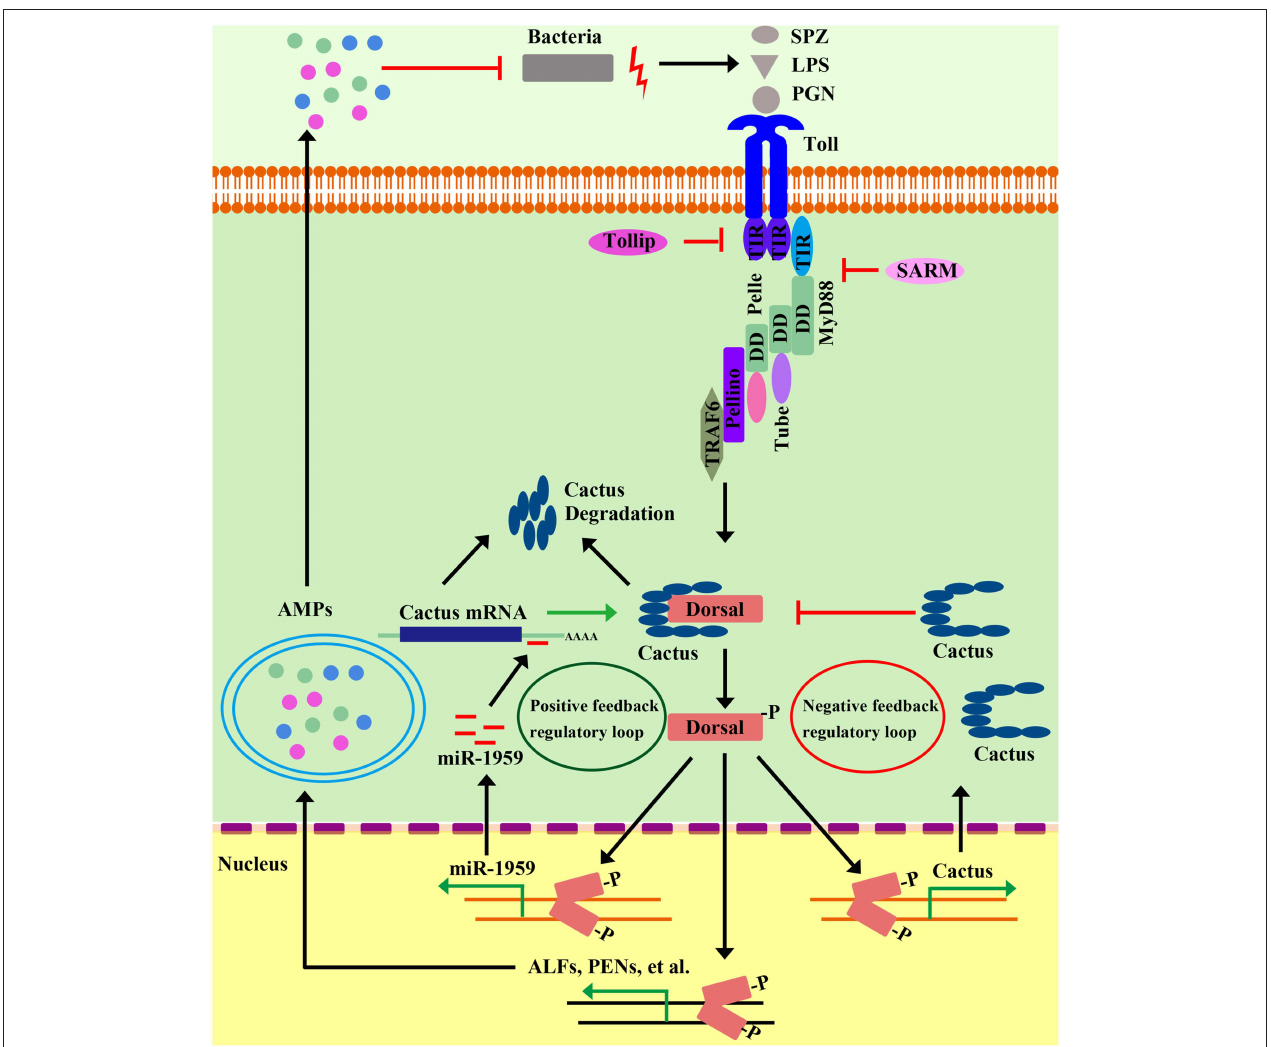
FIGURE 3 | Positive and negative regulatory events in shrimp Toll pathways. Positive regulation of the shrimp Toll pathway can amplify signaling cascades to rapidly limit and clear invading pathogens. In microbial recognition, intracellular signaling leads to activation of Dorsal, which in turn induces the transcription of a microRNA gene, miR1959. MiR1959 can target the mRNA of Cactus, an inhibitor of Dorsal, resulting in reduced Cactus protein levels, which leads to the up-regulation of Dorsal activity to boost some effectors, such as AMP expression against invading microbes. On the other hand, the activation of the Toll pathway must be controlled and inhibited to ensure a properly timed and adjusted response. Along with the clearing of invading pathogens, the gradually increased Cactus leads to the inhibition of Dorsal activity by their direct interaction, which establishes a negative-feedback loop to abate NF- κ B pathway signaling to avoid the sustained activation of this pathway. In addition, there multiple negative regulators have been identified—including Tollip, SARM, FliI, and β -Arrestin—that modulate the Toll pathway in different